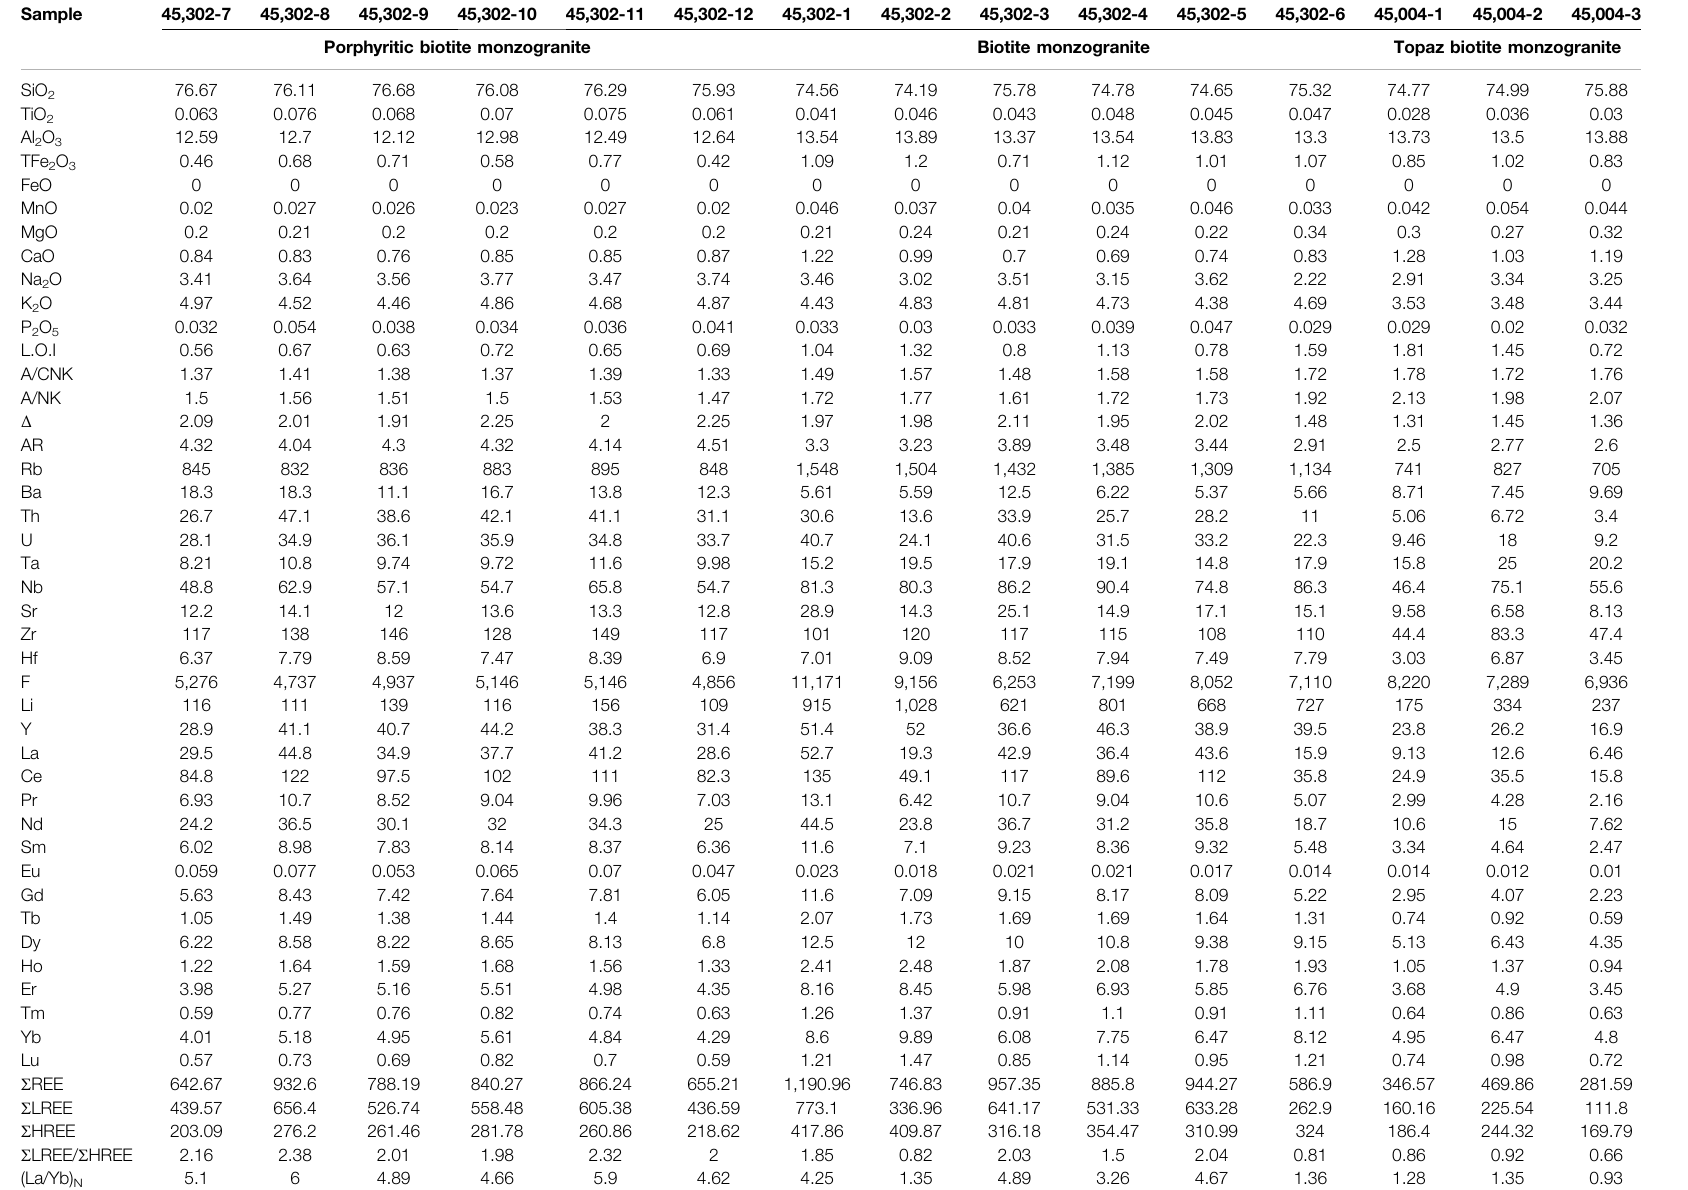
TABLE 1 | Whole-rock major and trace element compositions of the Jianfengling pluton.